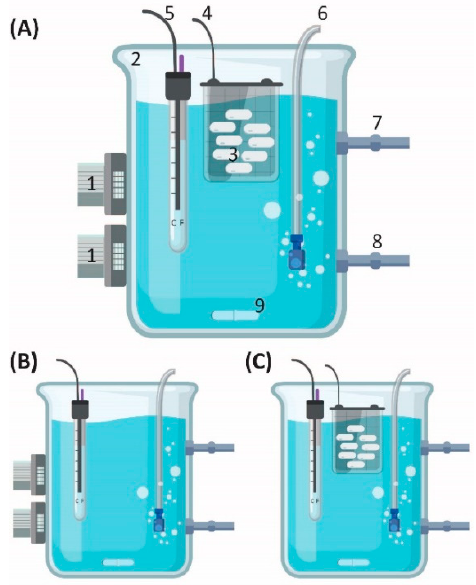
Figure 1. The OBR. ( A ) 1. UV-LEDs at two wavelengths, 267.7 nm and 277.4 nm; 2. quartz beaker of maximum 3.8 L volume (diam. 135 mm × height 280 mm); 3. SBP capsules; 4. beaker-shaped grid to hold the SBP capsules; 5. cool/warm water (thermostat); 6. air diffuser; 7. and 8. inflow and outflow stream to new OBR; 9. stirrer. ( B ) System without SBP capsules as a control. ( C ) System without UV-LED as a